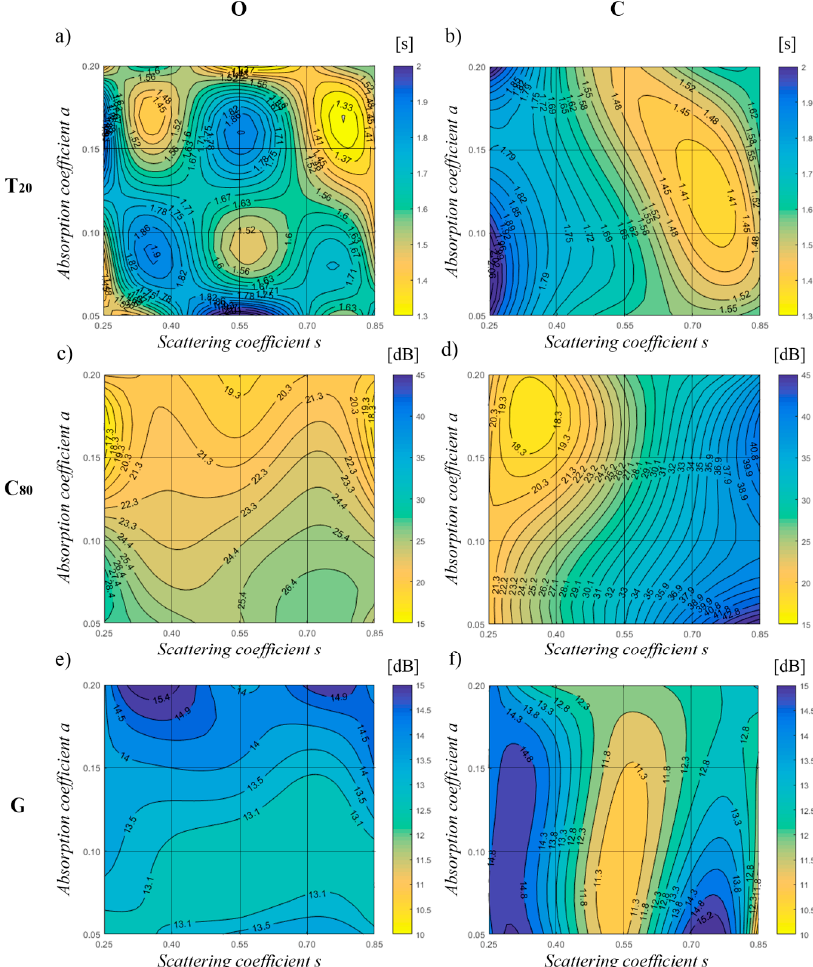
Figure 4. Sum of Absolute Differences (SAD) between the measurements and simulations overall the receivers, for T 20 , C 80 , and G in Odeon ( a , c , e ) and for CATT ( b , d , f ). Light yellow refers to very similar values between simulation and measurements.